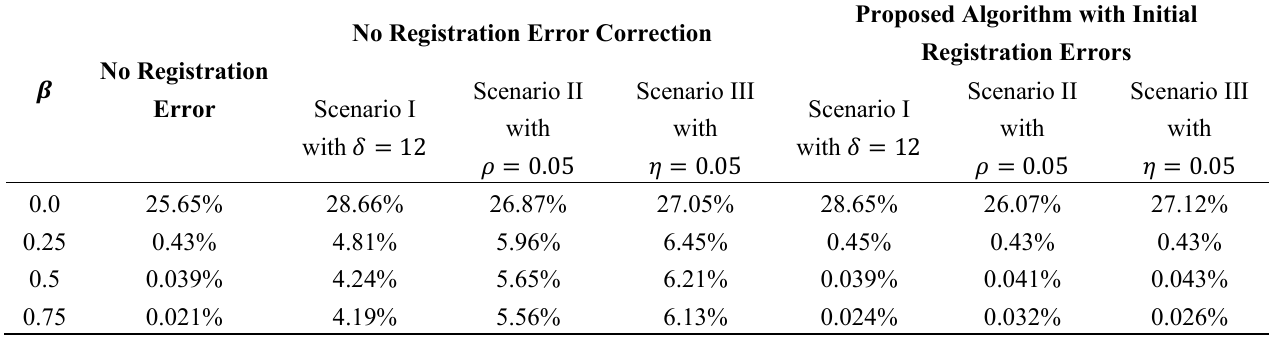
Table 2. Comparison of the averaged percentages of misclassified pixels (PMP) between two extreme cases and our proposed algorithm.